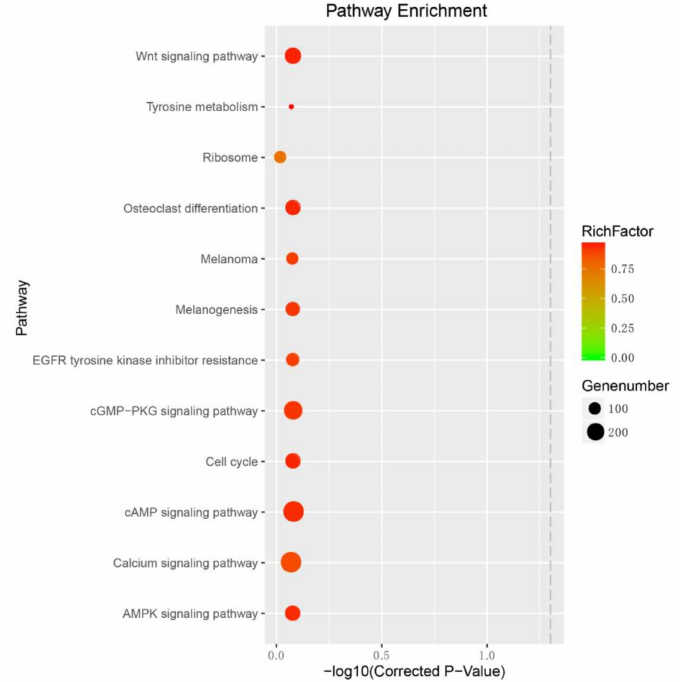
Figure 6. Pigmentation-related Kyotoo Encyclopedia of Genes and Genomes (KEGG) pathway of predicted target genes of Differentially Expressed miRNAs (DEMs) in red tilapia. Gene number—number of target genes in each pathway. Rich factor—the ratio of the number of target genes divided by the number of all the genes in each